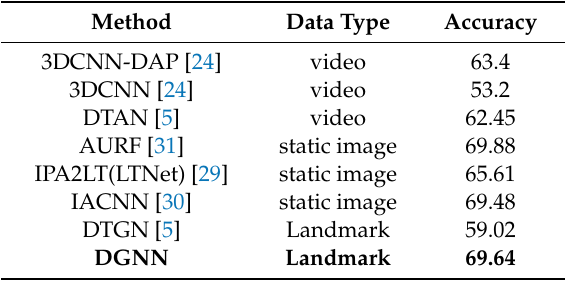
Table 3. Experimental results for the MMI dataset. The proposed method is highlighted in